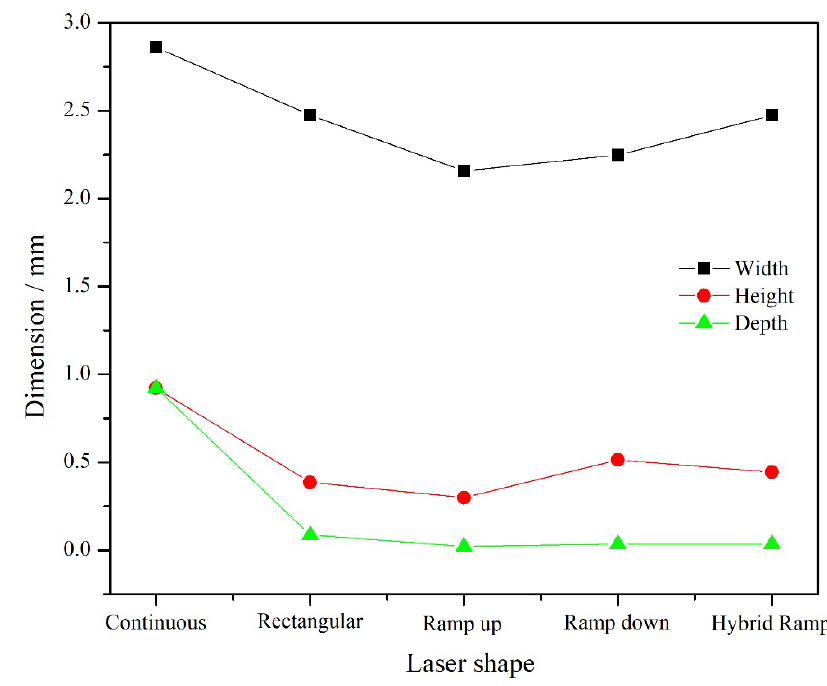
Figure 4. The width, height, and depth of single-track with different laser shape.